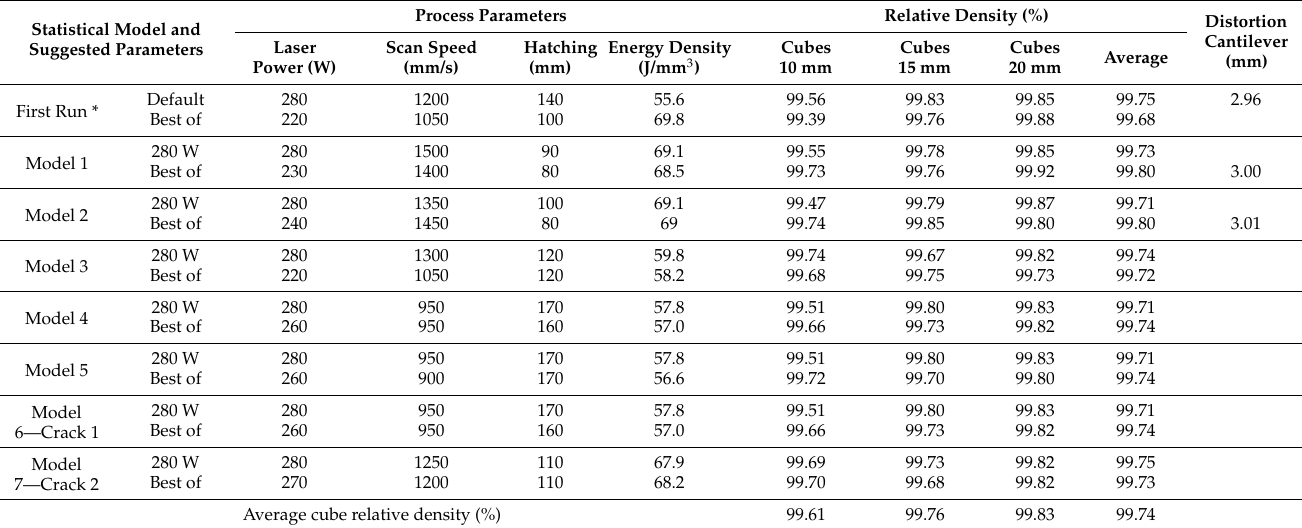
Table 5. Density results for the optimized parameters and different cube sizes plus distortion.